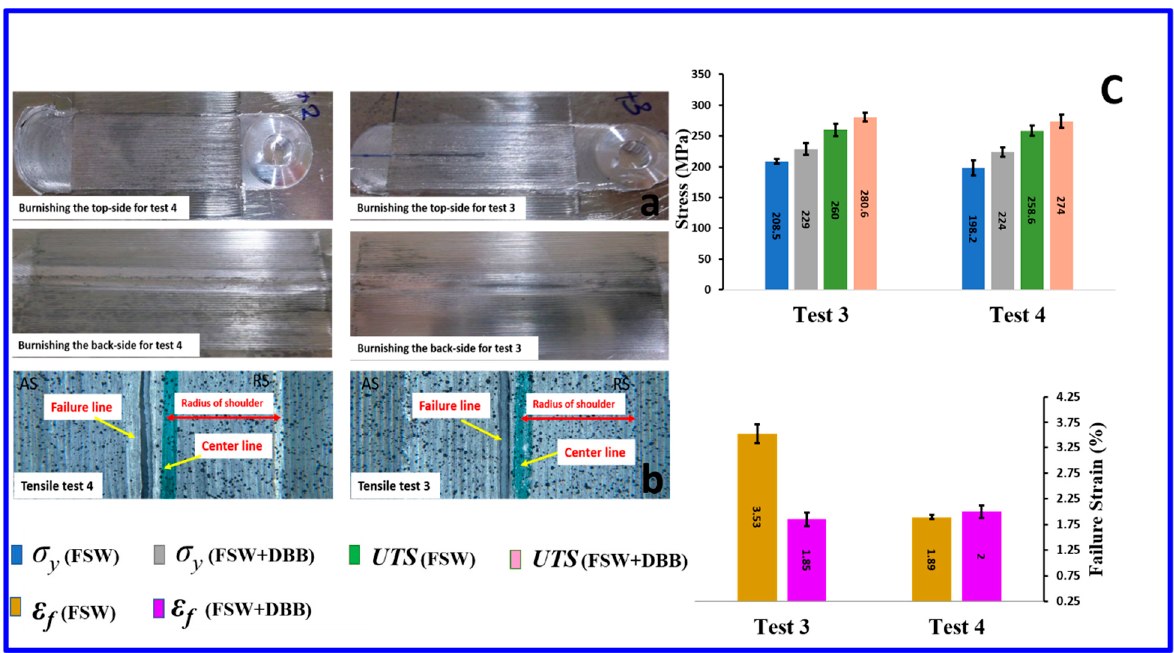
Figure 13. ( a ) Double-sided BB; ( b ) location of fracture line; ( c ) σ y , UTS , ε f for FSW tests 3 and 4 after DBB operation.